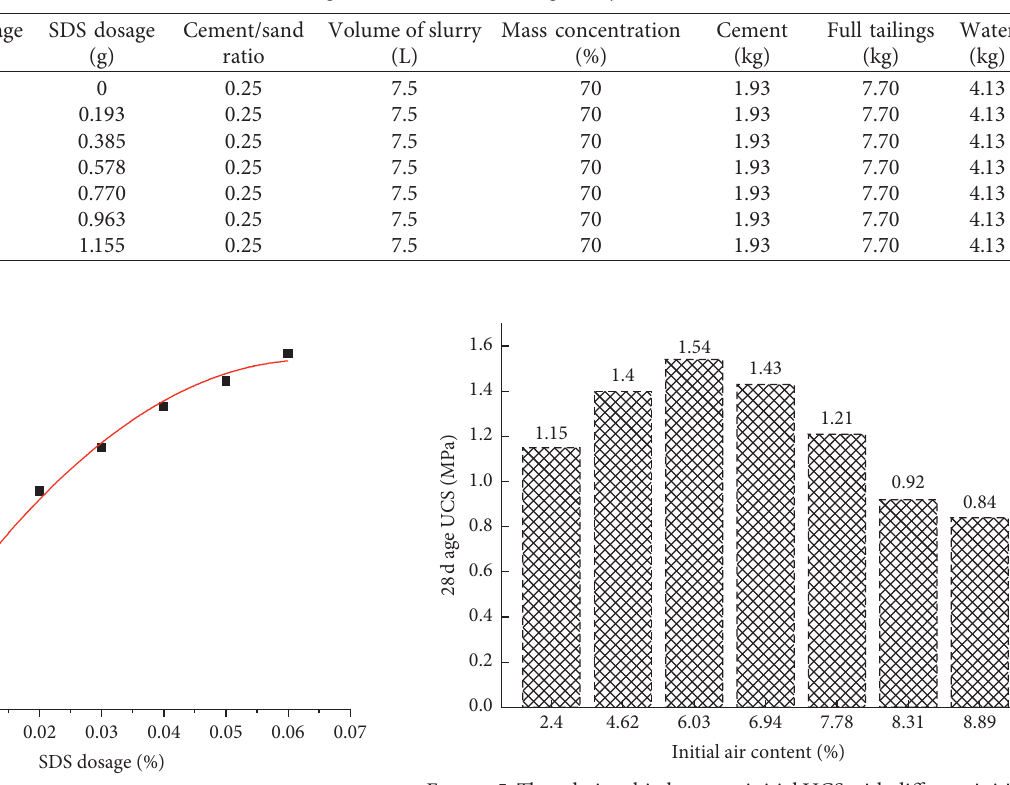
Table 2: Mixing ratio of the fresh filling slurry.